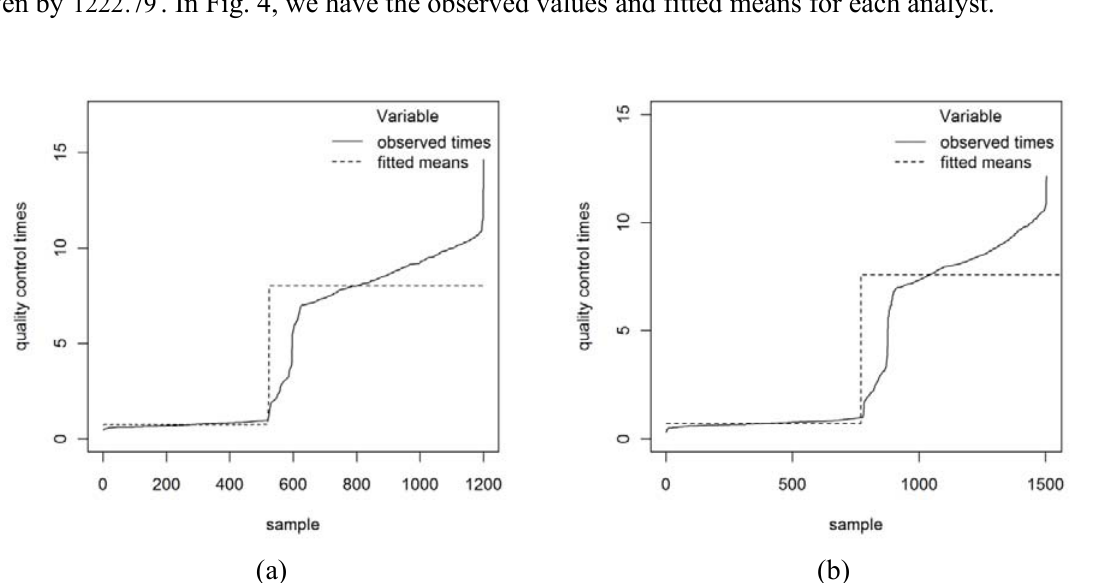
Fig. 4. Quality control times and fitted means versus samples: (a) Analyst 1 and (b) Analyst